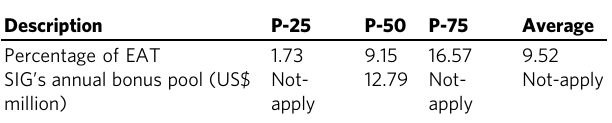
Table 5 SIG ’ s simulation to obtain annual bonus pool allocation in 2021.